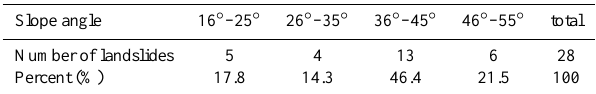
Table 3. Number of earthquake-induced landslide in different seis- mic intensity area.